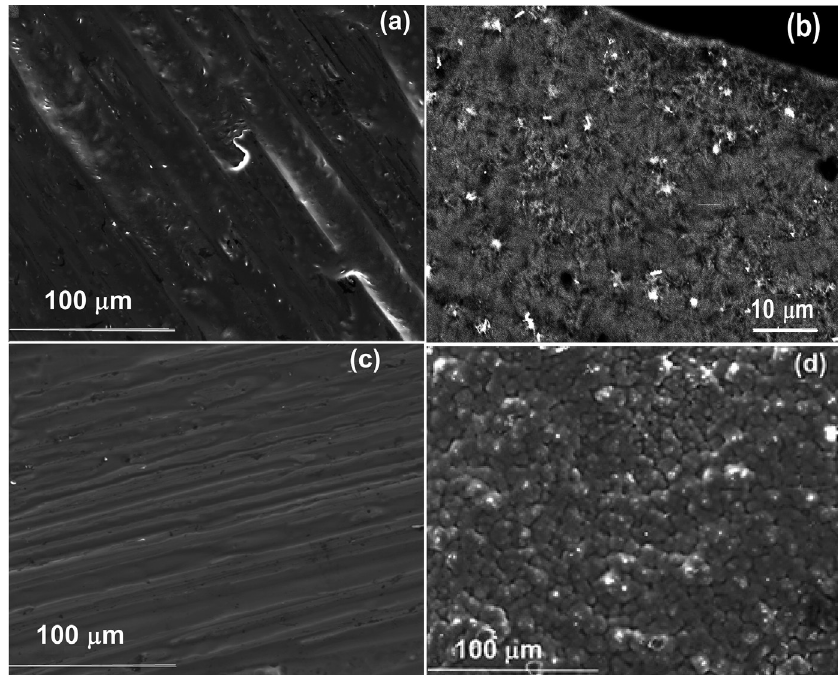
Cu sample; (b) BSE image of a cross section of 90 10